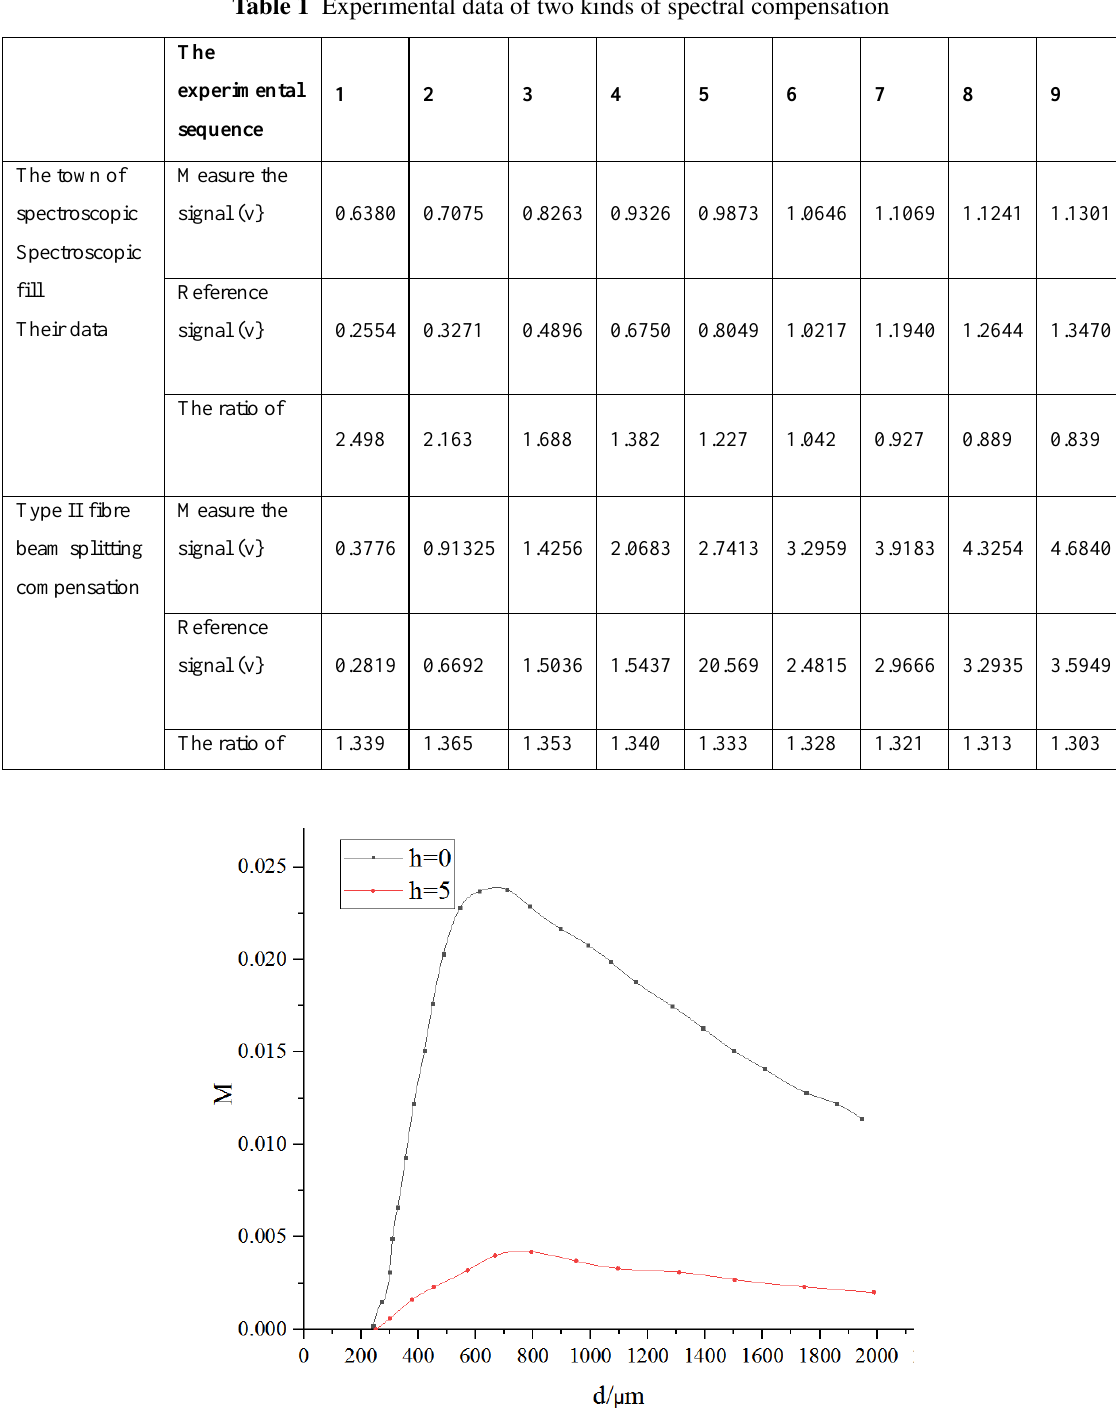
Fig. 1 The influence of specular and diffuse reflection on the characteristic curve of light stress control function light received by the receiving fibre decreases, and the light emphasis control function decreases accordingly; With the increase of the distance between the core and the shaft, the curve of the optical stress characteristic function decreases and moves backward, and the peak distance gradually increases with the increase of the